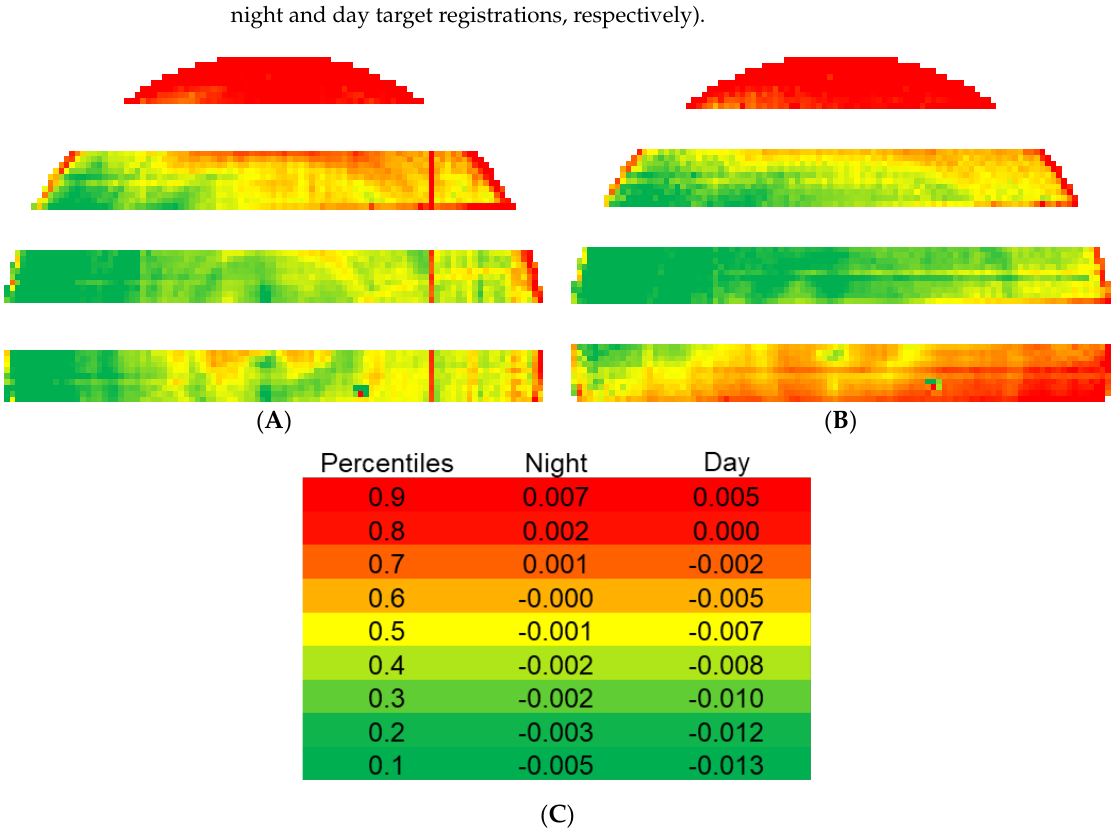
Figure 32. Livox ® Mid–40 distribution of error in ( A ) night and ( B ) day experiments, ( C ) colored by percentile.